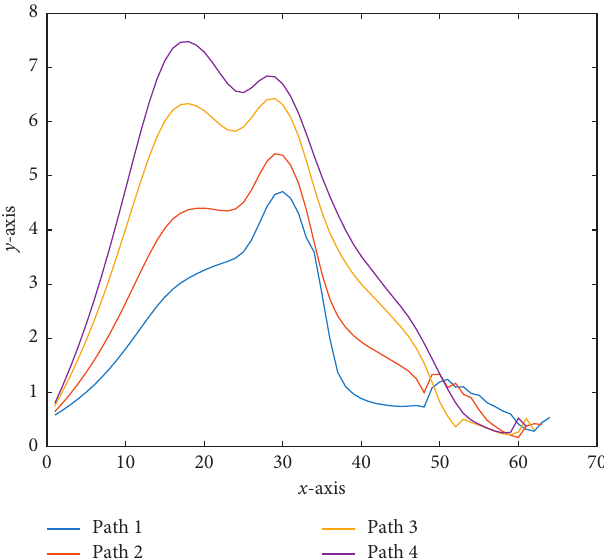
Figure 5: The height curves of four planned paths according to different saturation λ .